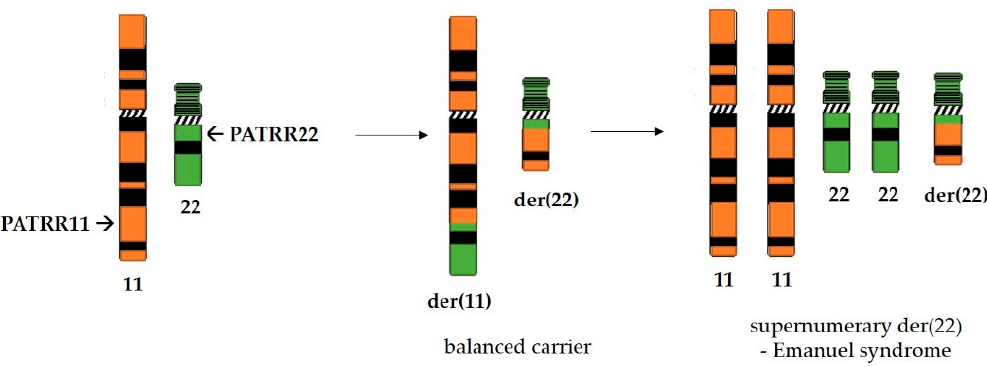
Figure 4. Reciprocal translocation between palindromes PATRR11 on chromosome 11 and PATRR22 on chromosome 22 in the human genome produces a generally healthy balanced carrier. However, offspring who inherit the supernumerary derivative der(22) alongside the normal chromosomal set suffer from Emanuel syndrome.